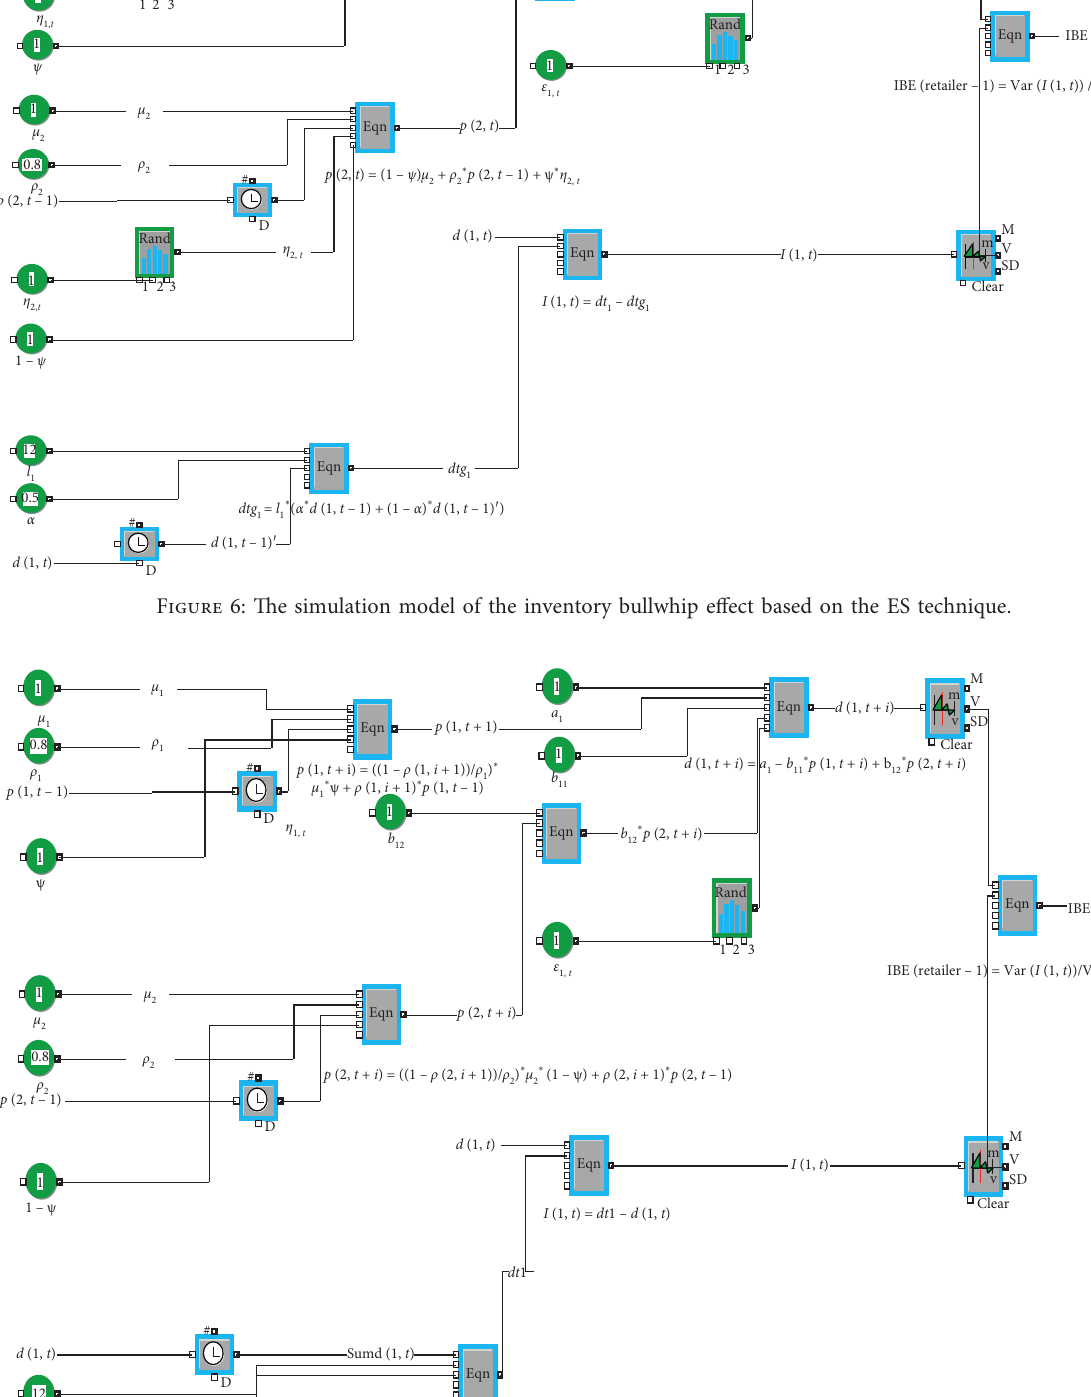
Figure 7: The simulation model of the inventory bullwhip effect based on the MMSE technique.